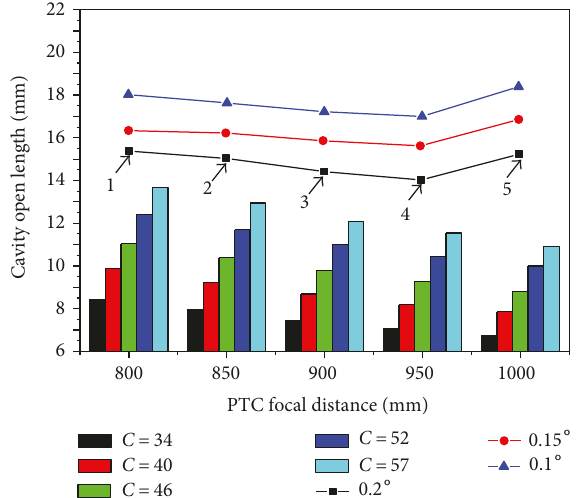
Figure 4: Relationship between the PTC focal distance and cavity open length under di ff erent concentration ratios and tracking error angles.